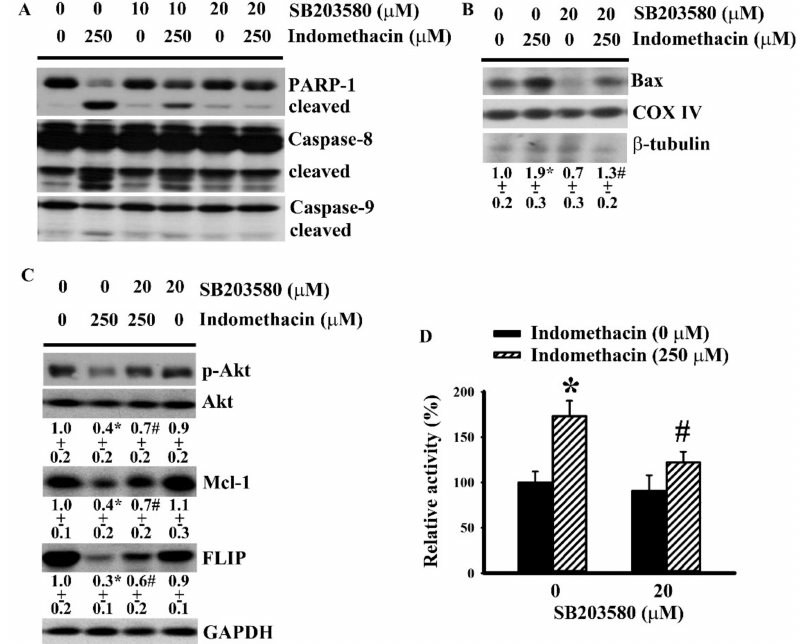
Figure 3. Indomethacin induced apoptotic signals in H4 cells. ( A ) H4 cells were treated with indomethacin (0 and 250 µ M) in the presence of various concentrations of SB203580 (0–20 µ M) for 5 h. Proteins were isolated and subjected to Western blot with indicated antibodies. H4 cells were treated with indomethacin (0 and 250 µ M) in the presence of SB203580 (0 and 20 µ M) for 5 h. Proteins obtained from mitochondrial fraction were subjected to Western blot with indicated antibodies ( B ). Proteins were isolated and subjected to Western blot with indicated antibodies ( C ). PP2A activity was assessed by enzymatic assay ( D ). Representative blot of three independent experiments is shown (A–C). Relative protein content was depicted under the blots (B and C). * p < 0.05 vs. untreated control and # p < 0.05 vs. indomethacin alone control (250 µ M), n = 3.